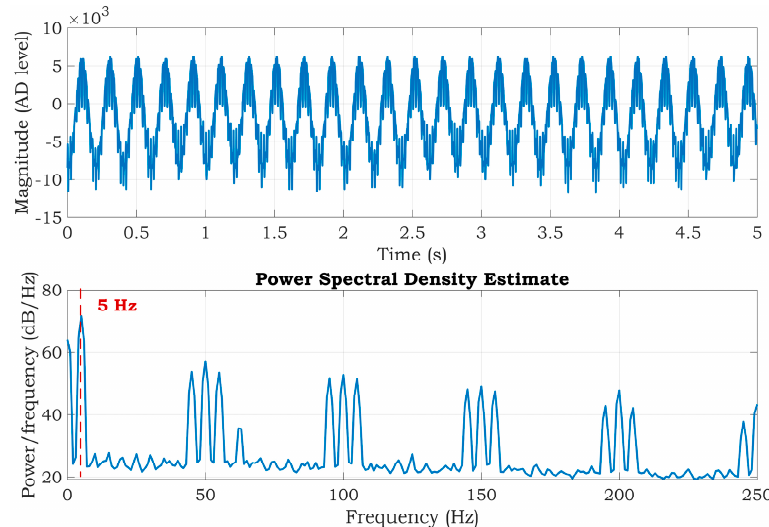
Figure 6. The first 5 s of the output signal (top) and PSD estimate (bottom) of the three-electrode system with a disabled DRL